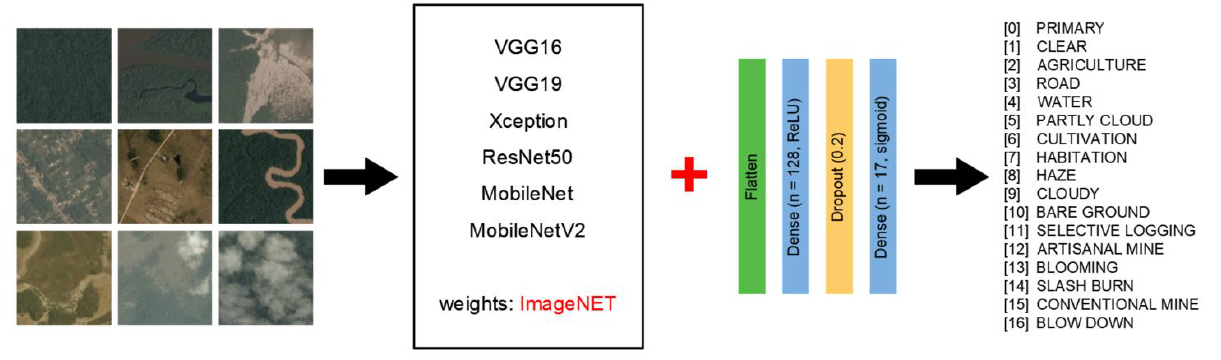
Figure 4 . Network training